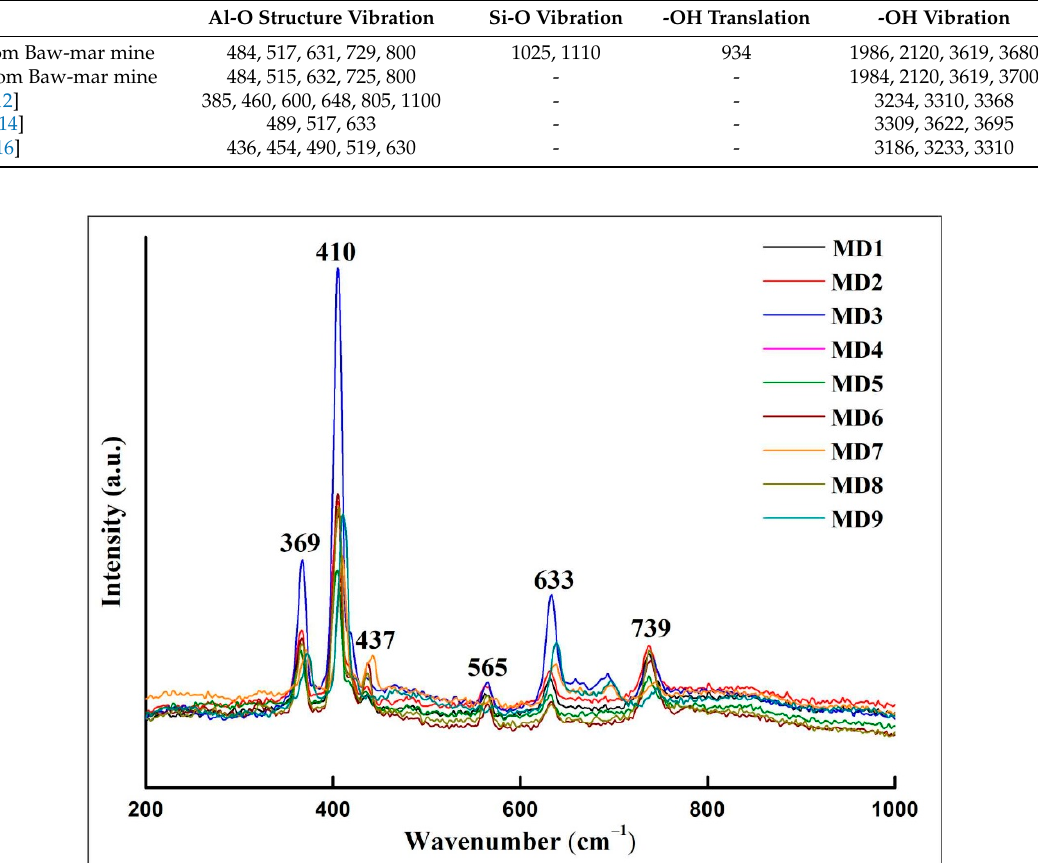
Figure 7. Representative Raman spectra of sapphire. Table 4. Raman peak frequency and attribution of Sapphire. (cm − 1 ).